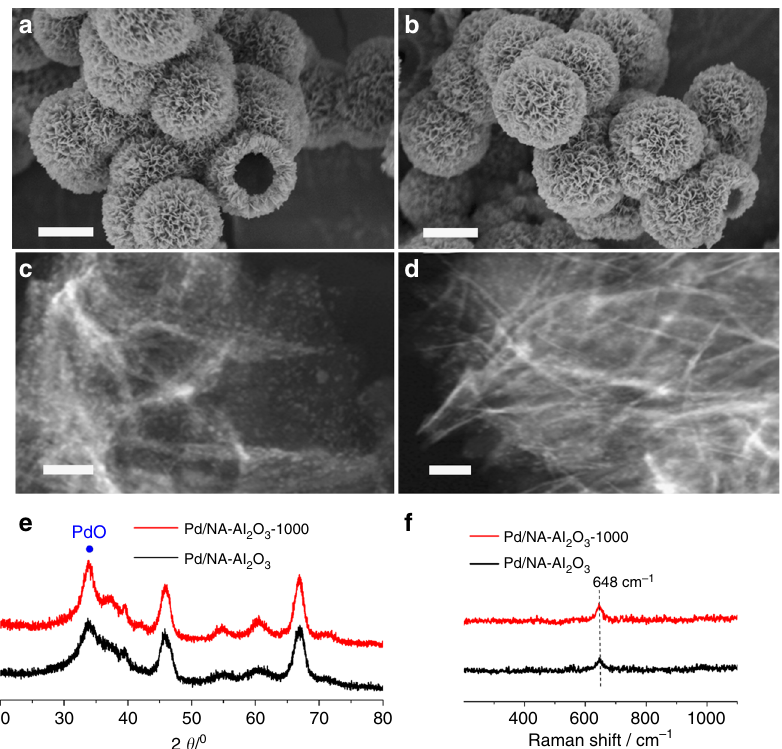
Fig. 3 Thermal characterization of Pd/NA-Al 2 O 3 nanocatalysts. a SEM images of Pd/NA-Al 2 O 3 . b SEM images of Pd/NA-Al 2 O 3 -1000. c TEM images of Pd/NA-Al 2 O 3 . d TEM images of Pd/NA-Al 2 O 3 -1000. e XRD patterns of Pd/NA-Al 2 O 3 -1000 and Pd/NA-Al 2 O 3 . f Raman spectra of Pd/NA-Al 2 O 3 -1000 and Pd/NA-Al 2 O 3 . The scale bar in a and b corresponds to 2 µ m, and in c and d corresponds to 50